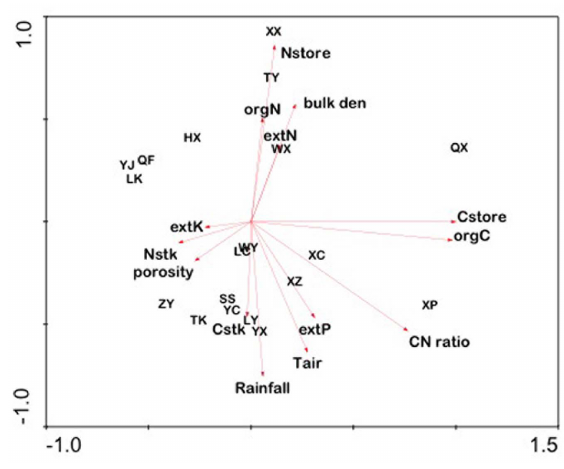
Figure 5. Principle components analysis of environmental and soil variables for agricultural soils in 19 counties within Henan Province. Length of arrows is directly proportional to their importance in explaining spatial patterns in the counties. Direction of the arrows indicates increasing values. Thus, the x-axis is primarily a gradient in soil C, whereas the y-axis is primarily a gradient in soil N and rainfall and secondarily a gradient in soil N. See Table 1 for key to county name